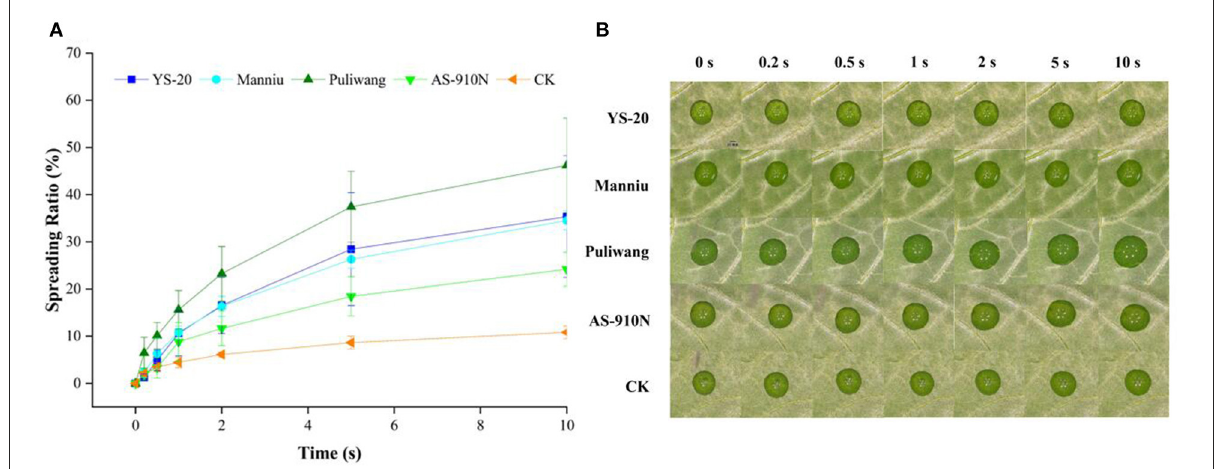
FIGURE4 Effect of aerial spray with adjuvants on spreading ratio line graph (A) and experimental images (B) .